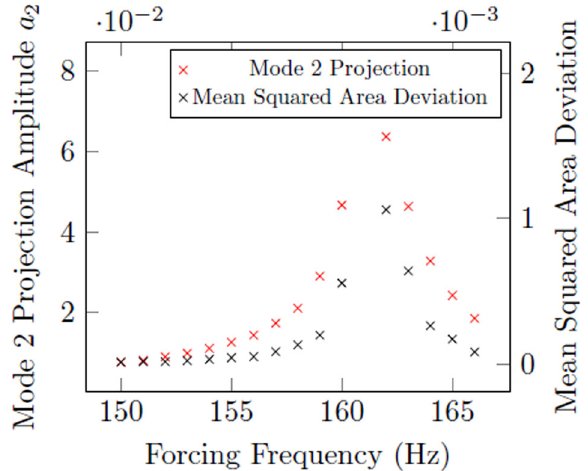
Fig. 6 Comparison of results from an area array and projection method for mode 2 resonance. Sample is 57.345 mg Inconel 625 at 1350 ∘ C .